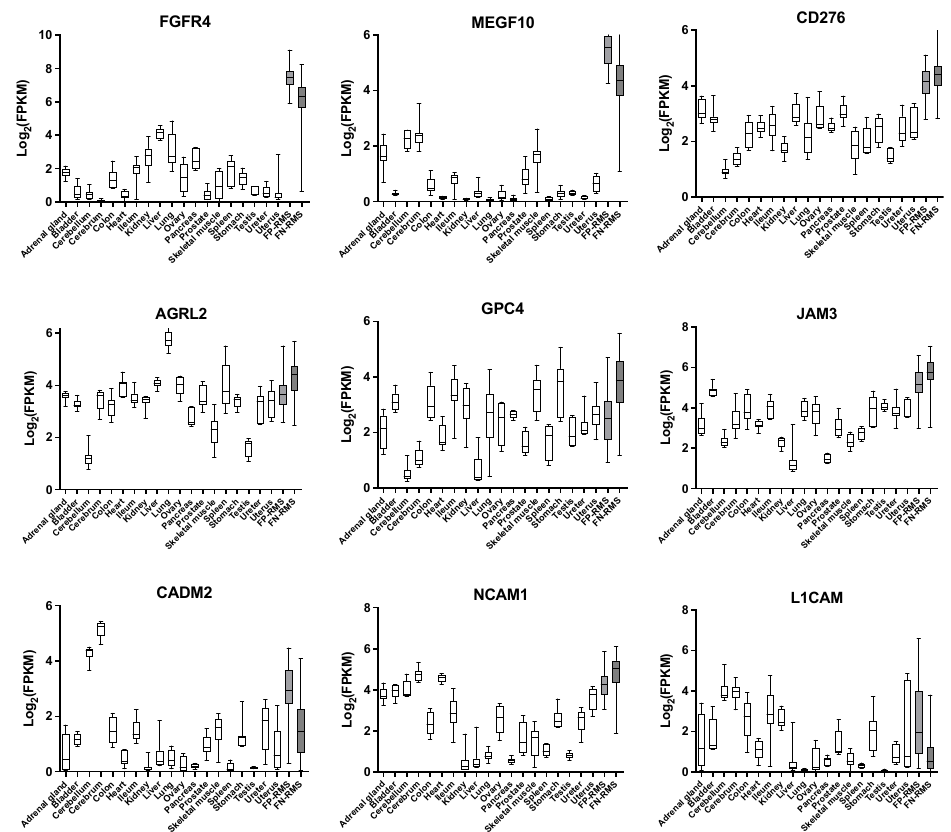
Figure 6. Transcript expression of selected candidates in RMS patients’ samples and normal tissues. Transcript numbers were obtained from a published RNAseq data set of 38 FP-RMS, 60 FN-RMS, and 5–20 normal tissues per organ [49]. FGFR4 , MEGF10 , and CD276 show a clear higher expression in tumors (grey boxes) compared to normal tissues (white boxed). Box and whiskers show the median with the 25th to 75th percentiles. Bars represent the minimum and maximum values.